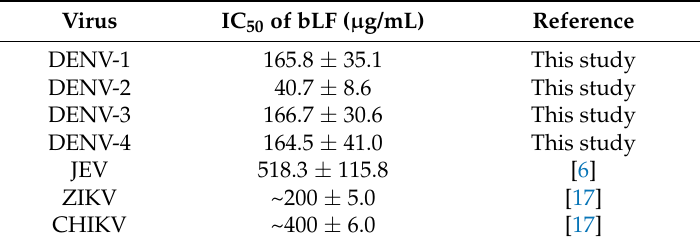
Table 1. Half maximal inhibitory concentration (IC 50 ) of bLF added during the whole virus infection